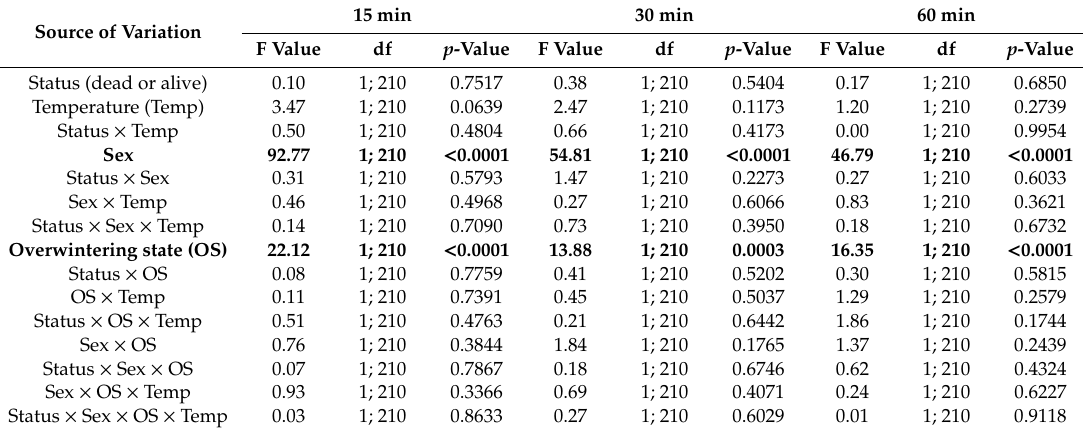
Table 3. E ff ects of Halyomorpha halys weight on tested variables and their interactions. Significant p -values are indicated in bold. The × is used to indicate the interaction between sources of variation.